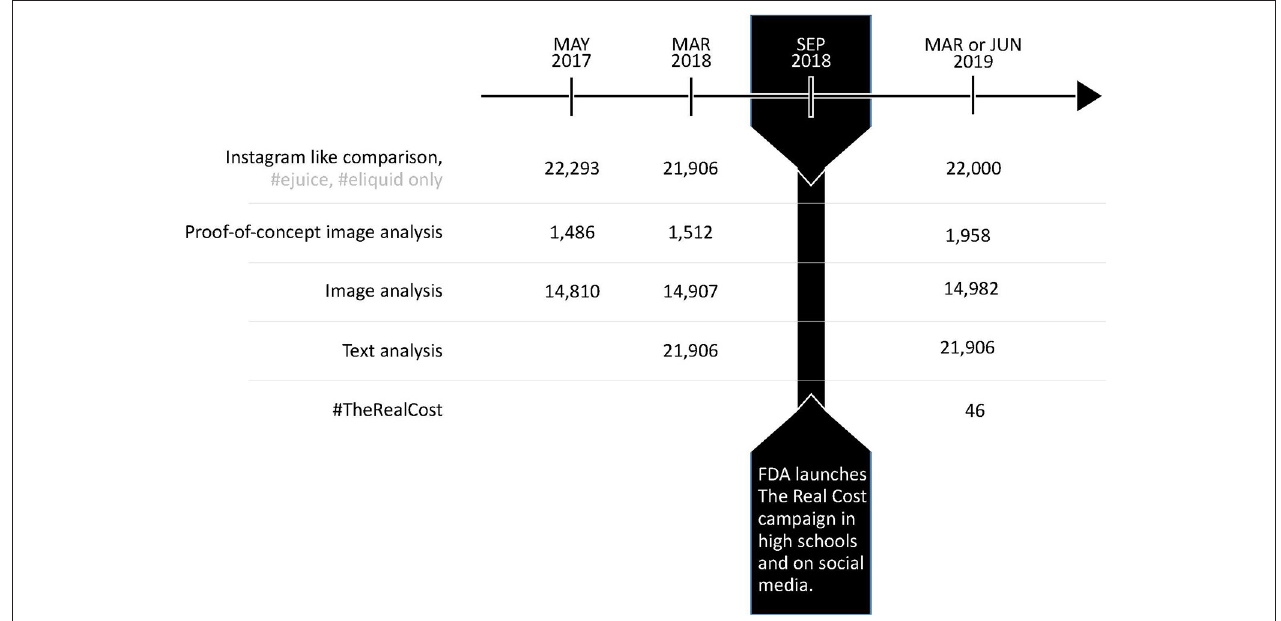
FIGURE 1 | Timeline for the collection of vaping-related Instagram posts.